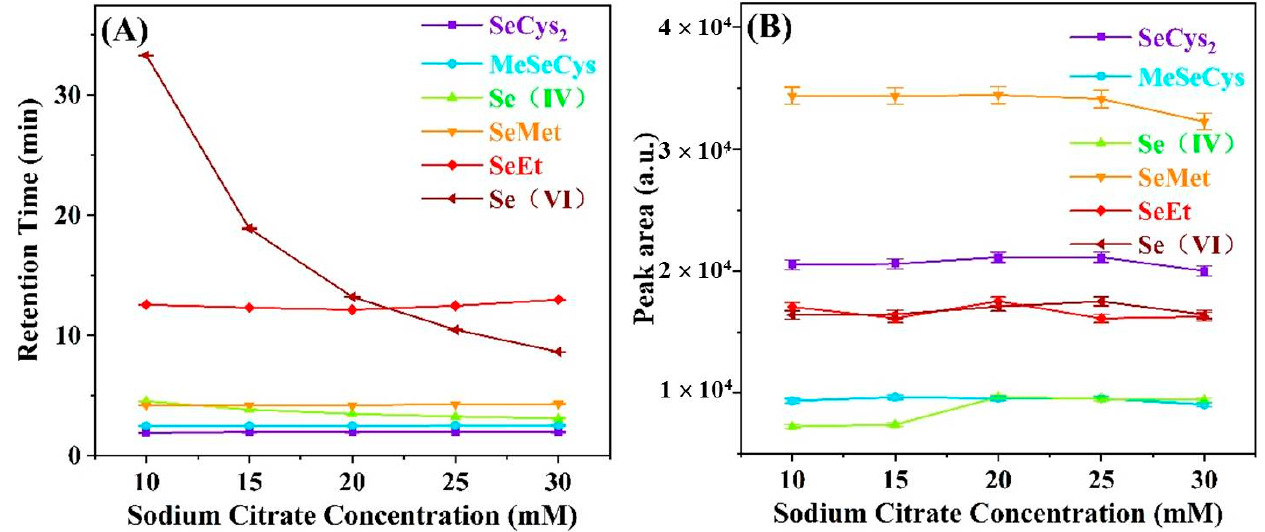
Figure 2. The effect of ionic strength in the mobile phase on ( A ) retention time and ( B ) peak area of SeCys 2 , MeSeCys, Se(IV), SeMet, SeEt, and Se(VI). Mobile phase conditions: 2% methanol, pH = 4.0, 1.0 mL min − 1 .